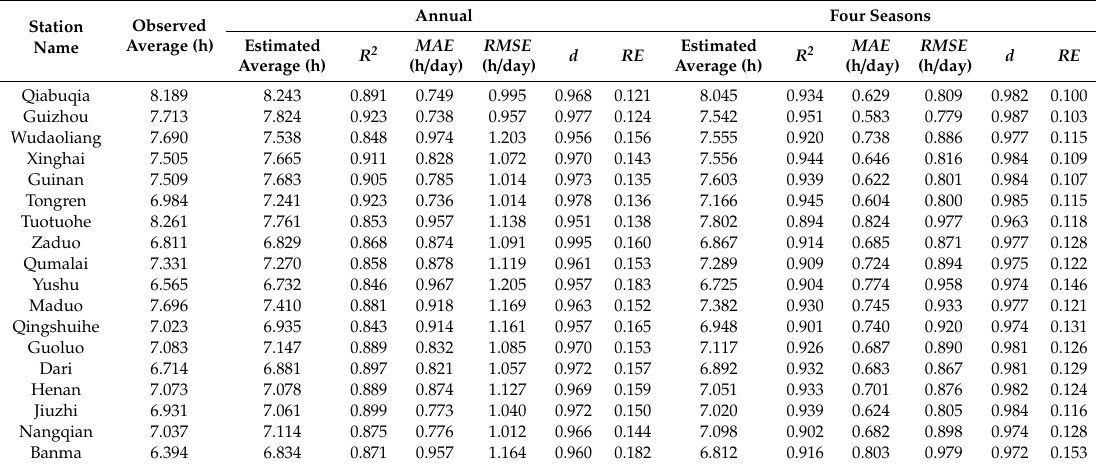
Table 4. Statistics for the estimation of daily sunshine duration (h) at each of the 18 meteorological stations daily in